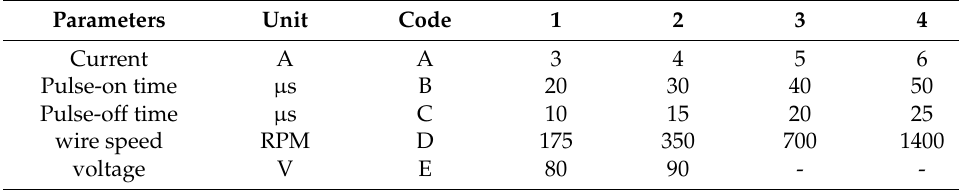
Table 2. Wire-EDM process parameters and settings.